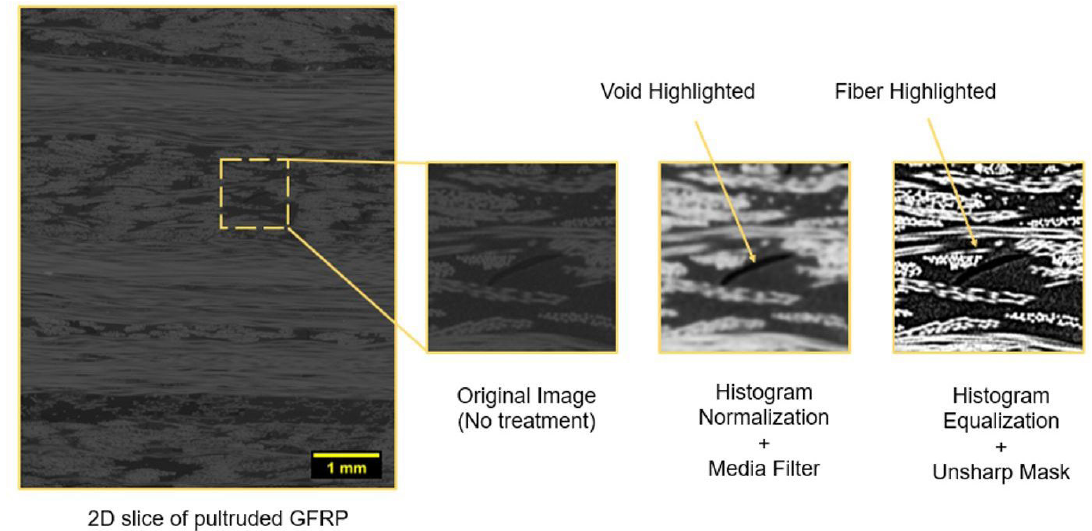
Figure 5. Different processing operations for highlighting fibers and voids for subsequent segmentation.